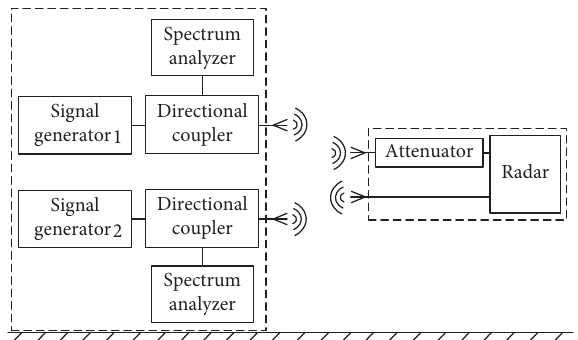
Figure 2: Layout of continuous wave electromagnetic radiation experiment on the